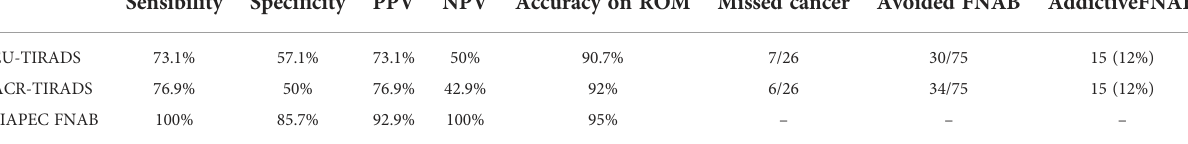
TABLE 5 Risk strati fi cation performance of EU-TIRADS and ACR-TIRADS in paediatric